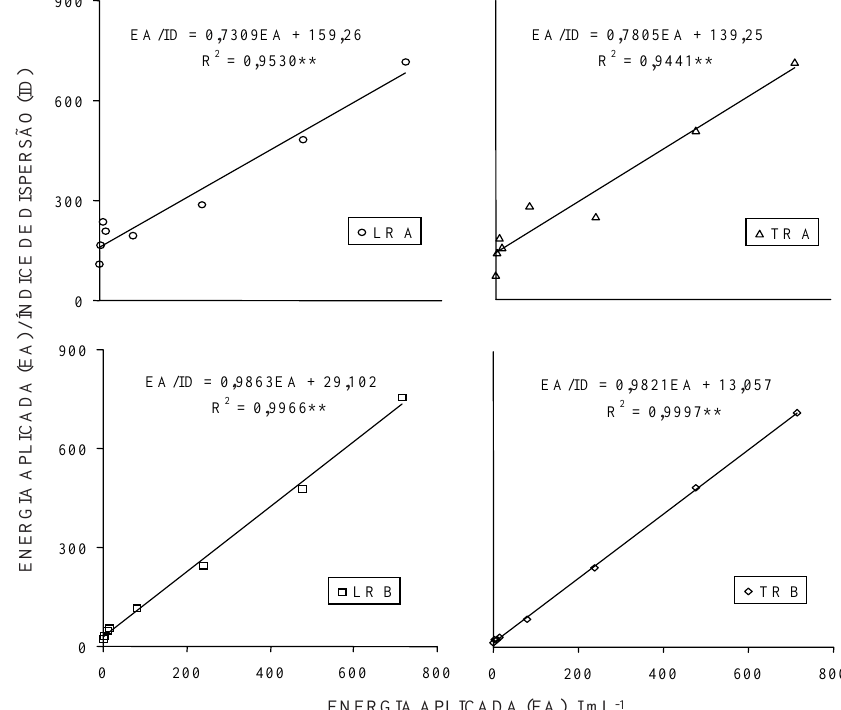
Figura 2. Curvas de dispersão linearizadas para os horizontes A e B do Latossolo Roxo e da Terra Roxa Estruturada (dados